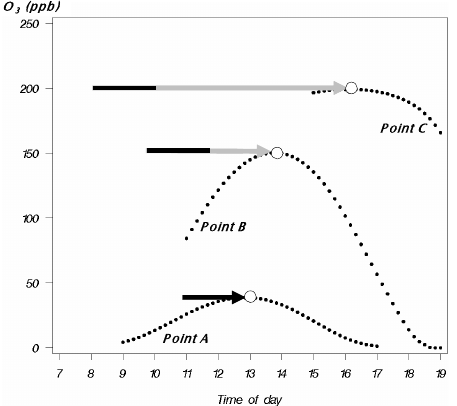
Fig. 6. Schematic diagram of time-dependent O 3 concentrations calculated at points A (near the source, D =2 h), B (middle range, D =4h), and C (remote, D =8h), by assuming a constant emission rate (beginning at 07:00 LT) and wind speed, with solar radiation and temperature dependent on the time of day. Arrows indicate the advection duration of the air mass bringing O 3max . The length L of the precursor source was assumed to be 2h (indicated by the black parts of the arrows).